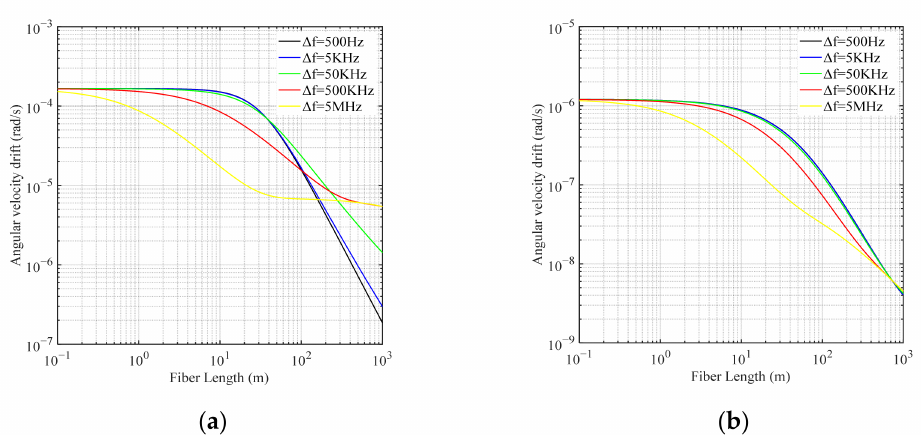
Figure 5. Angular velocity drift Ω bias induced by the Kerr effect as a function of the ring resonator length L in the case of different light source linewidths. ( a ) Drift of the conventional RFOG with a sing SMF ring resonator. ( b ) Drift of the PDHC-RFOG. Table 2. Parameters for the RFOG with a single SMF ring resonator and the PDHC-RFOG.